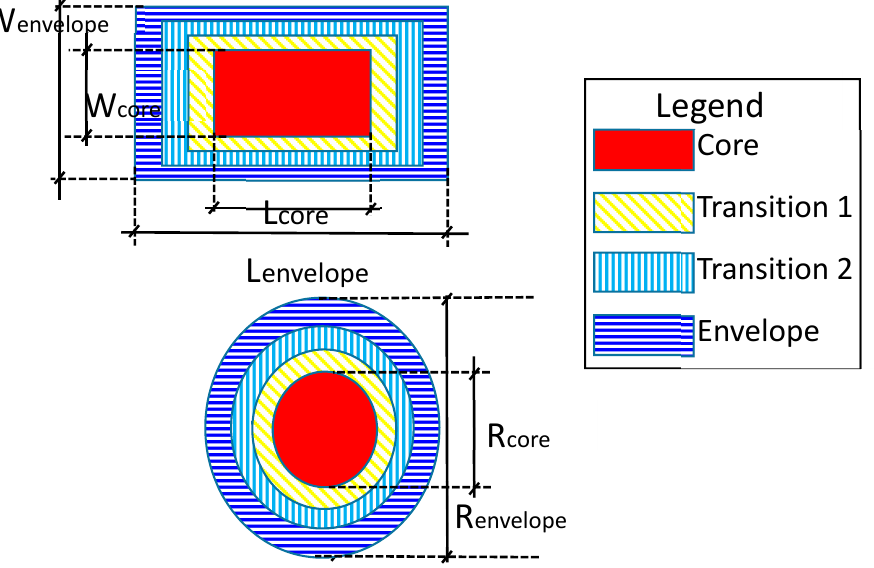
Figure 3. Parametric modeling of hazard severity.